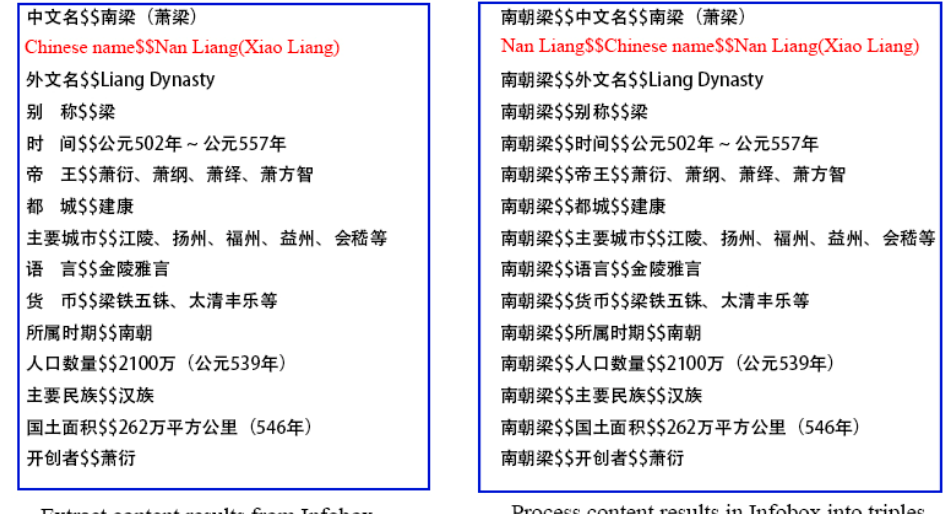
Figure 3. Data extraction results from InfoBox in Baidu Encyclopedia. The left side of the figure is to extract the information in Infobox, which mainly includes the contents of “basicinfo item name” and “basicinfo item value” in the information box, and the $ symbol is used for segmentation in the middle. On the right side of the figure is the triple data result of information processing in the extracted and